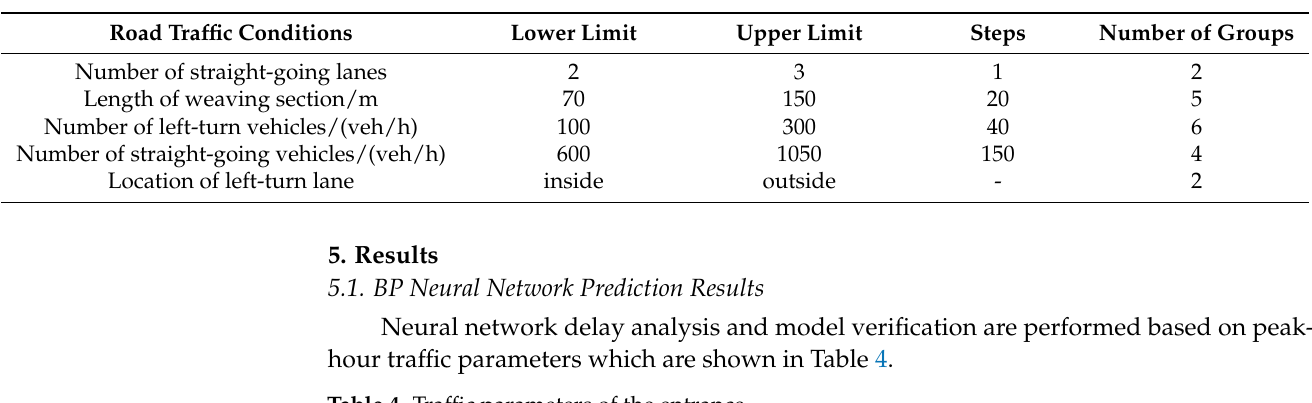
Table 4. Traffic parameters of the